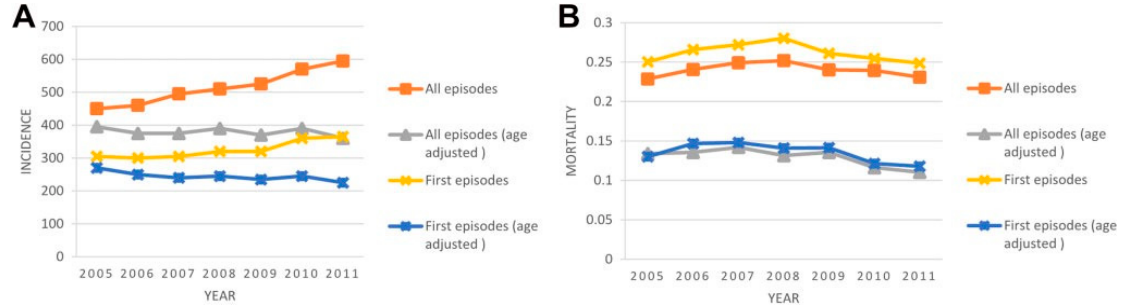
Figure 1. Incidence and mortality of sepsis in Taiwan (incidence presented as event per 100,000 population). ( A ) Incidence trend of severe sepsis. ( B ) In-hospital mortality trend of severe sepsis.